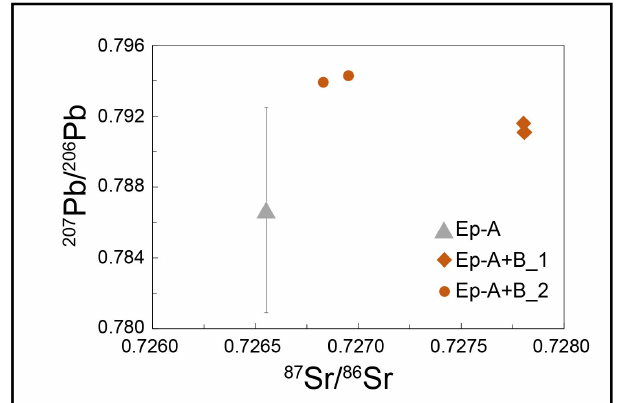
Figure 13. Total 207 Pb / 206 Pb and initial 87 Sr / 86 Sr data of Epidote-A (Ep-A) and epidote micro-separates (Ep-A + B_1 and Ep-A + B_2); the 207 Pb / 206 Pb ratio of Epidote-A is by LA-ICP- MS (analysis no. 10 of Peverelli et al., 2021; their Table 5); all other 207 Pb / 206 Pb ratios are by solution ICP-MS; 87 Sr / 86 Sr ratios are by TIMS; error bars are smaller than the symbols where not